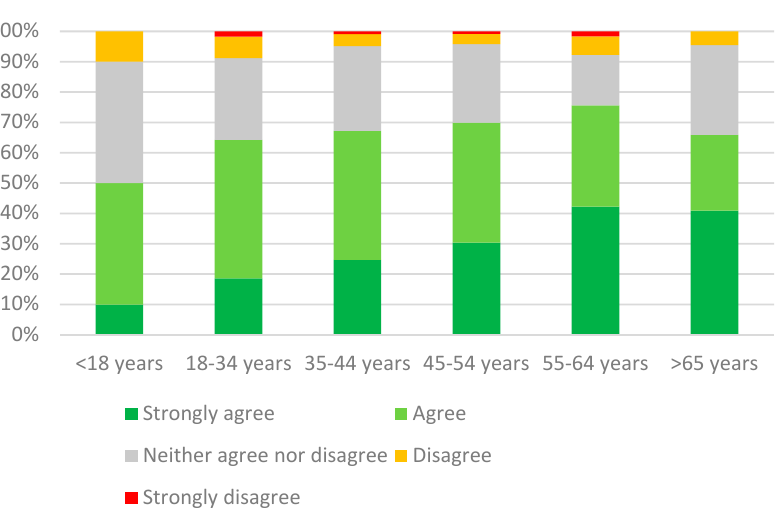
Figure 2. Degree of agreement for each age bracket with the statement: “the presence of preservatives in pet food could be harmful to my pet’s health”.